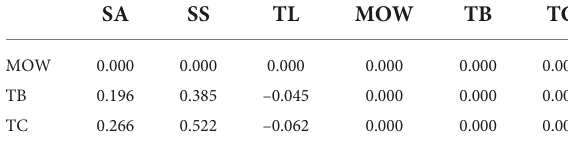
TABLE 7 Indirect